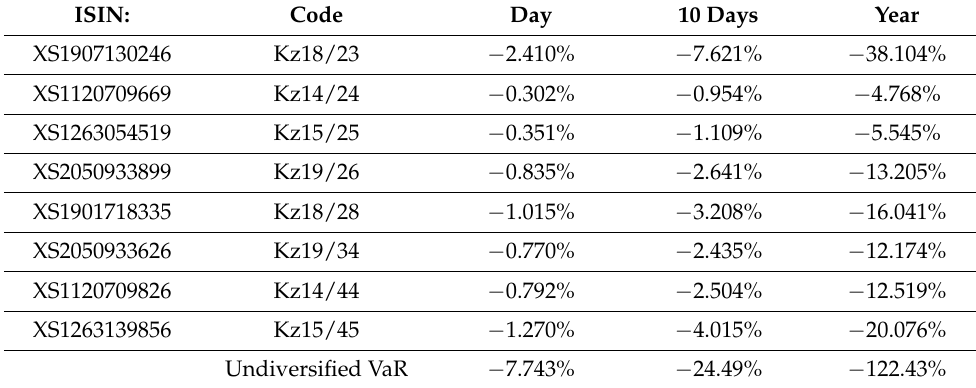
Table 1. The Value at risk for Kazakhstan’s Sovereign Bonds.